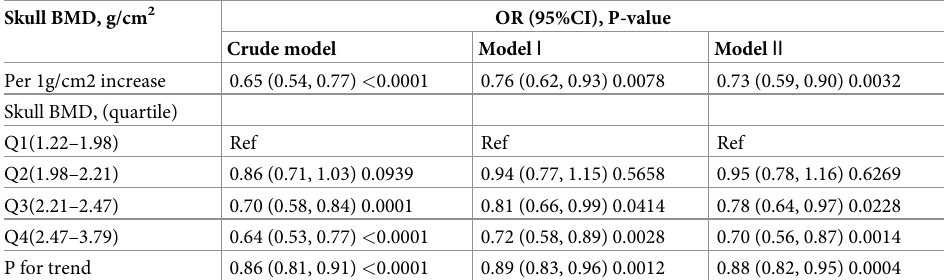
Abbreviations: BMD, bone mineral density. CI, confidence interval. OR, odds ratio. Crude model adjust for: